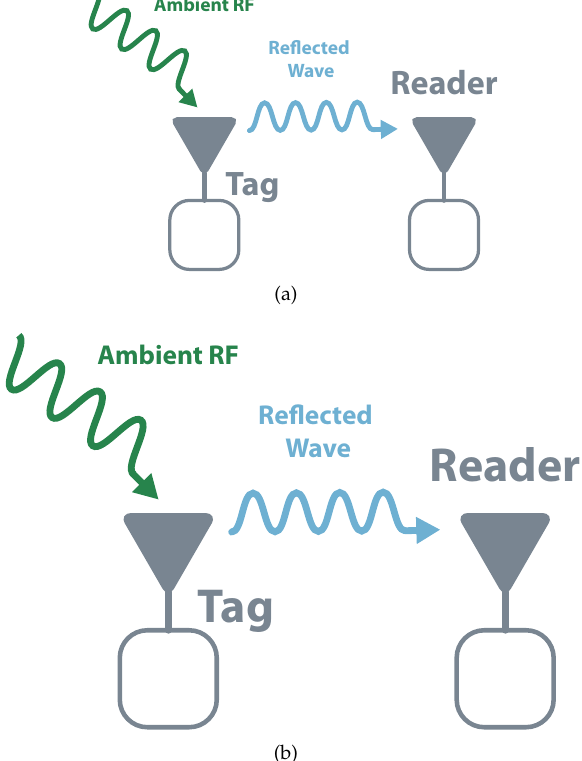
Figure 5. Backscatter systems without dedicated interrogators or readers. ( a ) Ambient backscatter ( b ) Proprietary